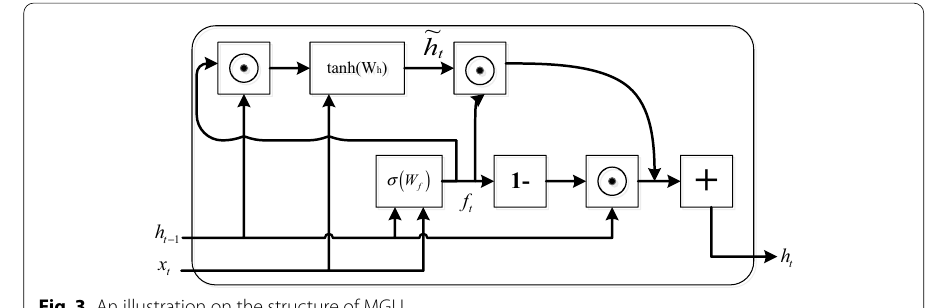
Fig. 3 An illustration on the structure of